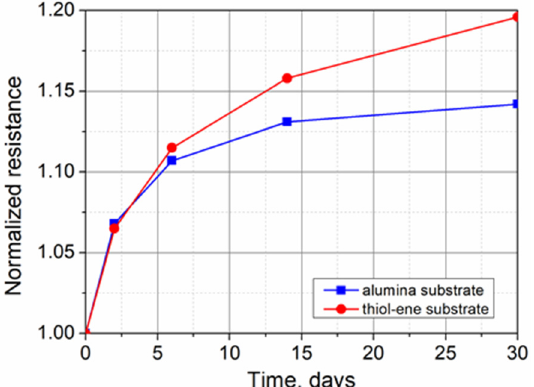
Figure 7. Evolution of the electrical resistance of PEDOT:PSS films on alumina and thiol–ene sub- strates with time over a period of 1 month.